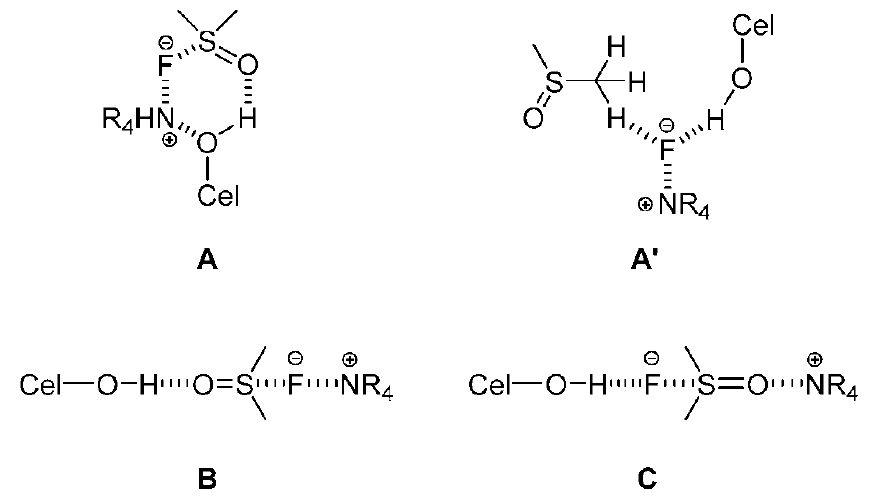
Figure 11. Schematic representations of cellulose / DMSO / IL structures, including the starting geometries of the aggregates ( A – C ), ( A’ ) is an optimized geometry of ( A ), redrawn from [87], with permission from Elsevier, 2014.